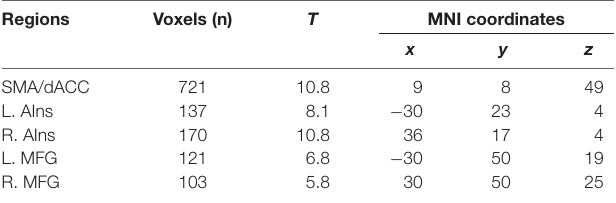
TABLE 1 | Regions of the salience network (SN) that are correlated with the task phase of AX-CPT. Regions Voxels (n)